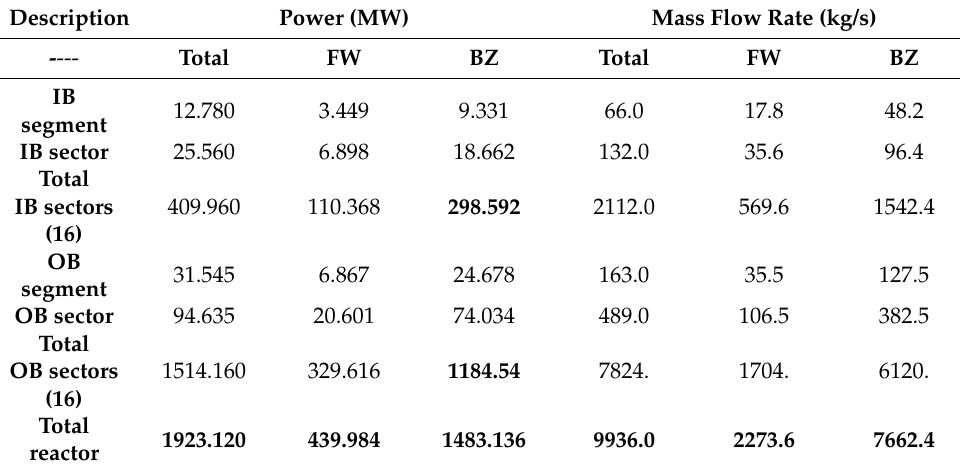
Table 3. WCLL DCD BOP BB power and coolant flow rates (TD 295–328 ◦ C) [3]. Description